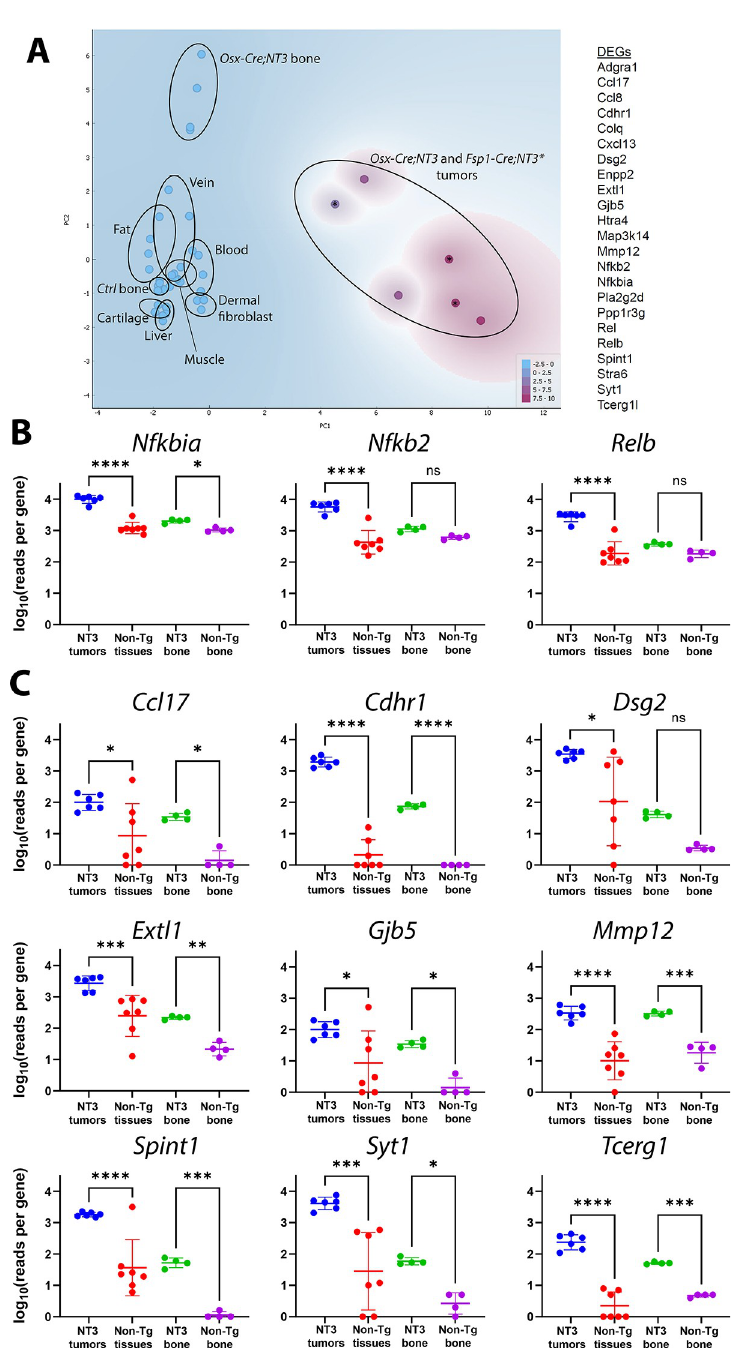
Fig 5. Tumors show strong expression of NF- κ B target genes. (A) Principal component analysis of Osx-Cre;NT3 tumors and FSP1-Cre;NT3 tumors (marked with � ), Ctrl and Osx-Cre;NT3 bone, and other normal tissues utilizing the 23 genes listed. Expression of (B) NF- κ B genes ( Nfkbia , Nfkb2 , and Relb ) and (C) 9 additional NT3 transgene targets previously identified as top DEGs in NT3 bone vs Ctrl bone, each with 2 or more κ B response elements. Log 10 (reads per gene) is shown from normalized RNA-Seq data. One-way ANOVA, followed by Dunnett’s multiple comparisons test; � , p < 0.05, �� p < 0.01; ��� , p < 0.001; ���� , p < 0.0001.